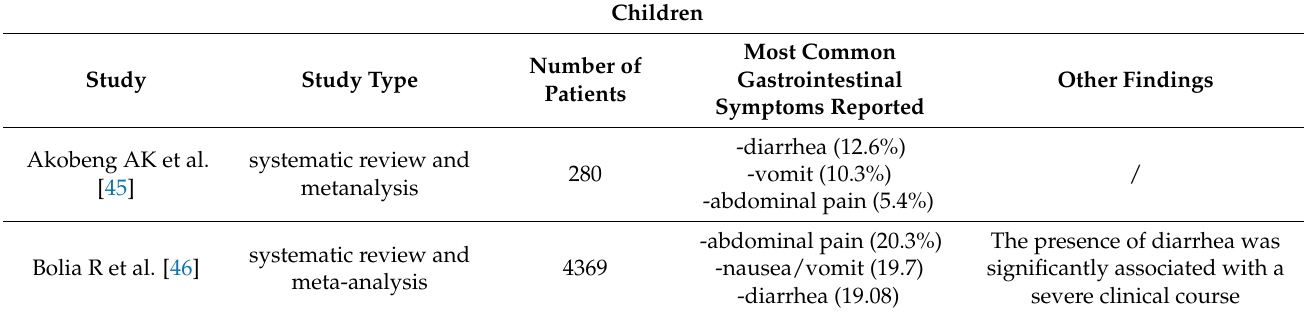
Table 2. Percentages of the main gastrointestinal manifestations of COVID-19 in children and adults, of different